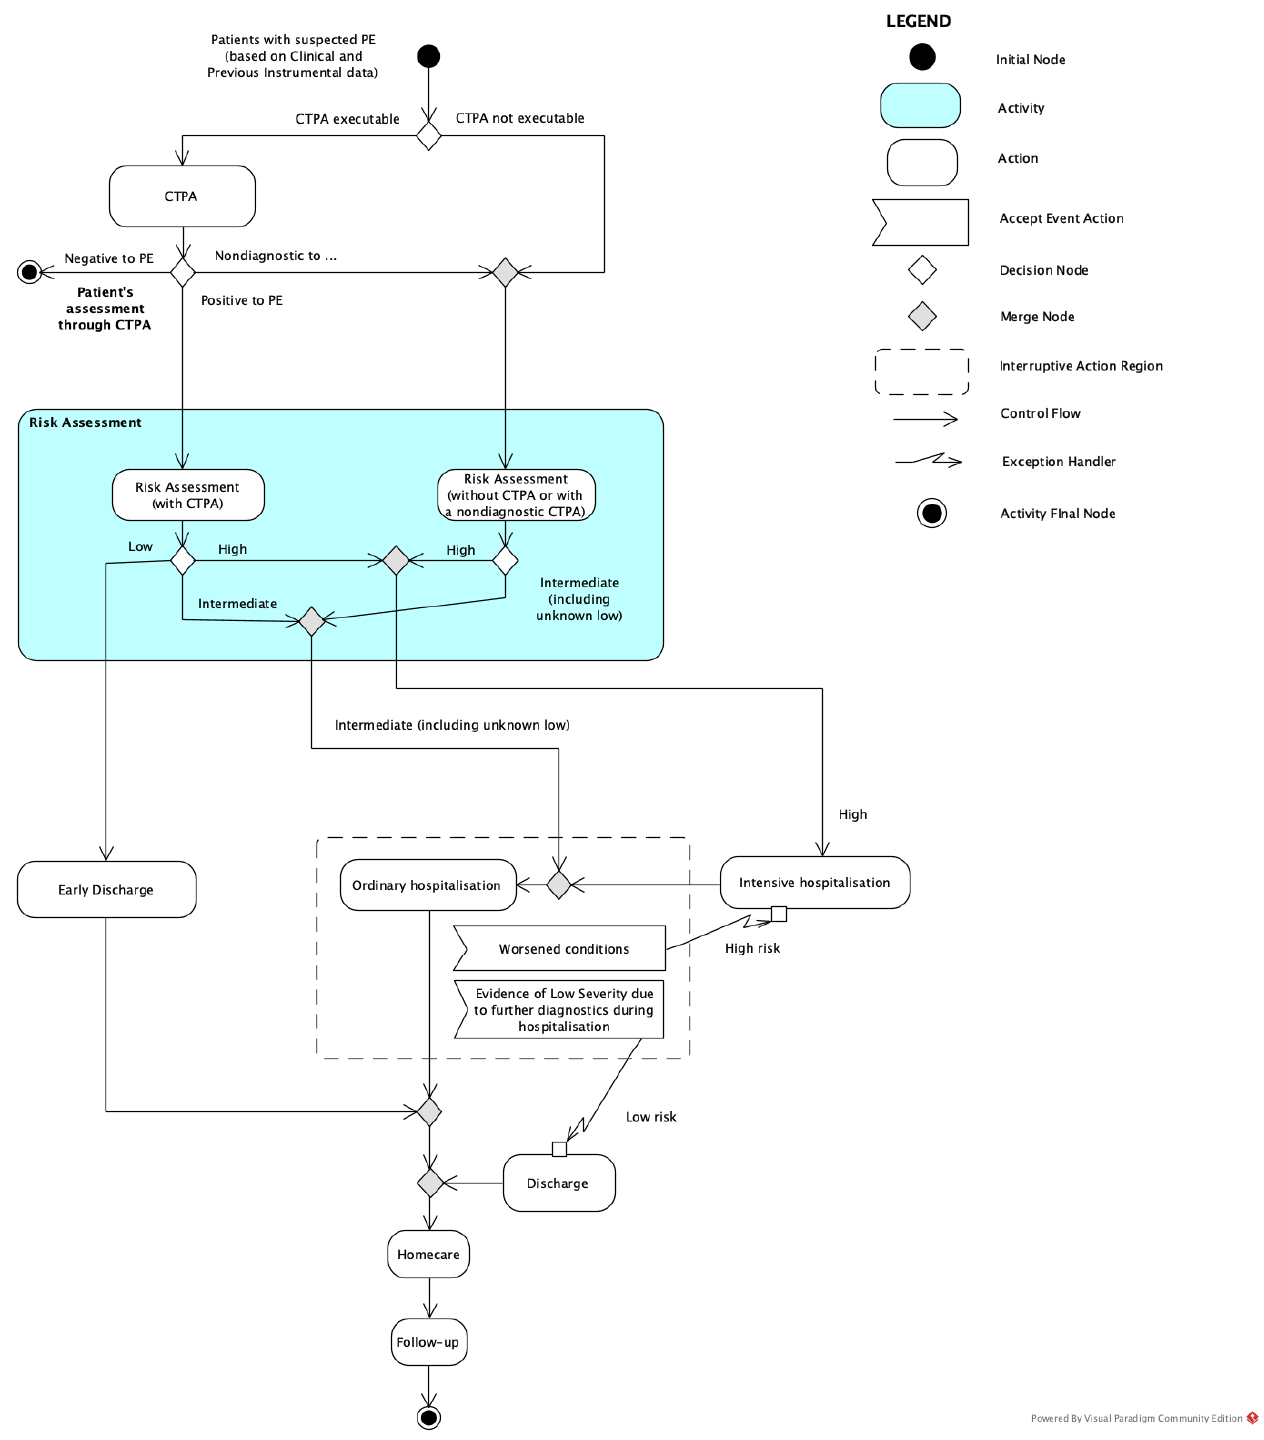
Figure 1. Representation of the conventional pathway: in the scenario where LPS is not performed, the patient is hospitalised both in the case of a CTPA-positive result and, precautionarily, in the case of non-conclusive or not-executable CTPA. On the other hand, Figure 2 represents the process for patients with a non-conclusive or not-executable CTPA when LPS is available (LPS model).